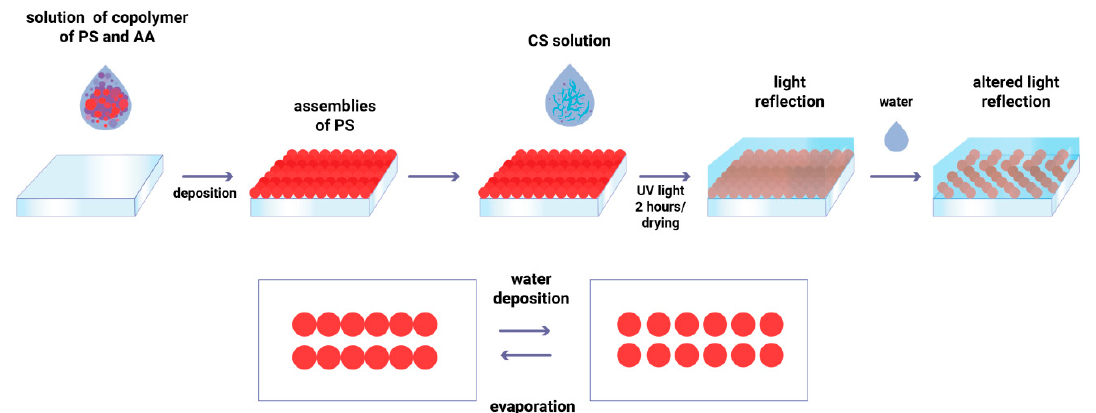
Scheme 1. Schematic illustration of the photonic coating creation. An image was displayed and hidden before and after water interaction, respectively.